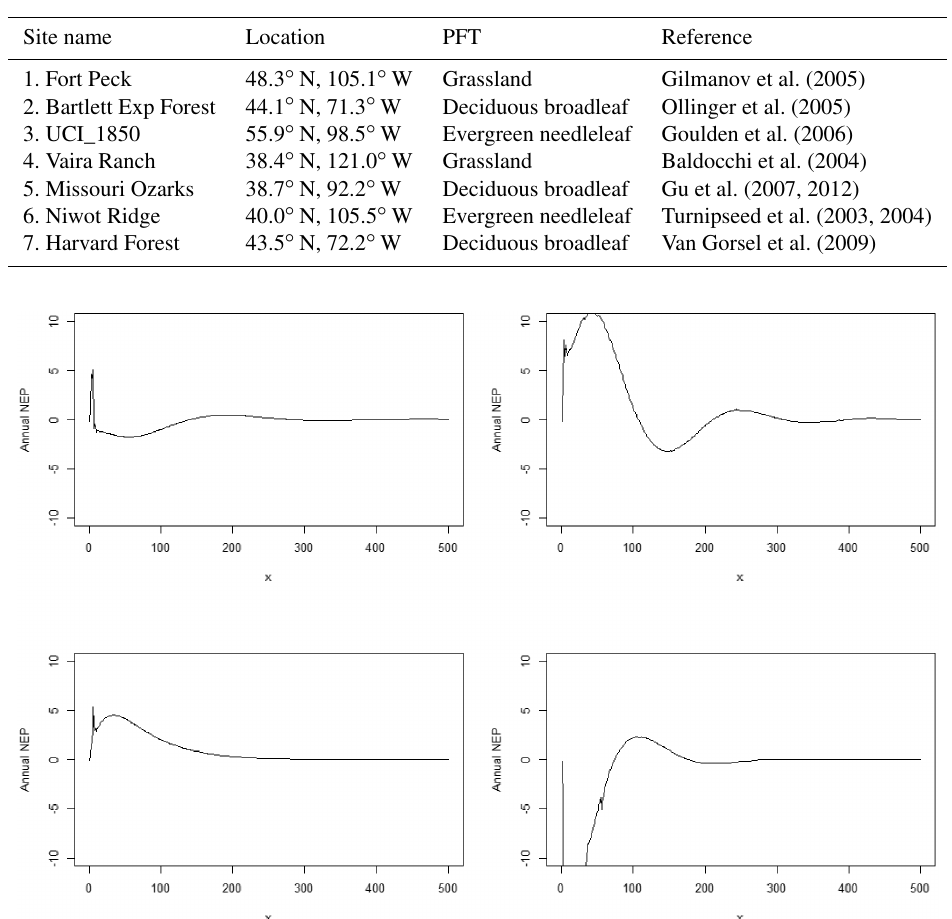
Table 1. Test sites for new spin-up algorithms.